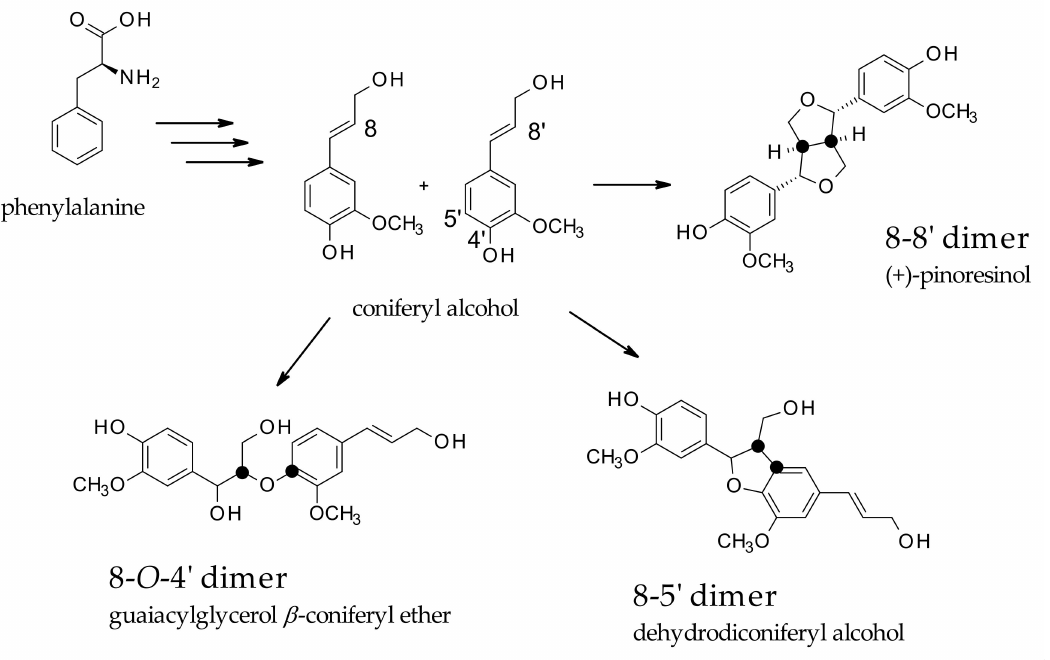
Scheme 1. Schematic representation of the formation of lignans (8-8 (cid:48) dimers) and neolignans (8- O -4 (cid:48) or 8-5 (cid:48)